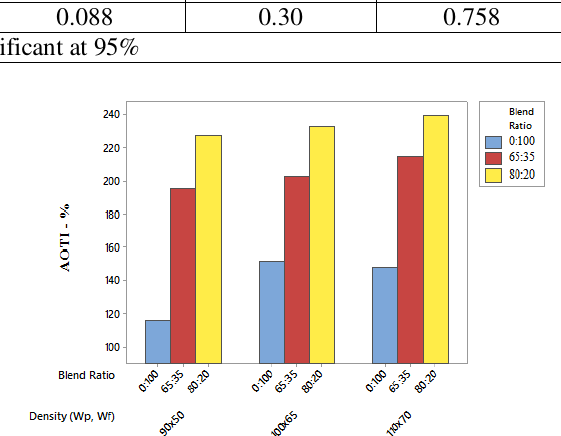
Fig. 1: AOTI Values of Developed Samples surface [4, 16] which is quite apparent from the wetting time of the bottom surface (WT b ) in Table 4.